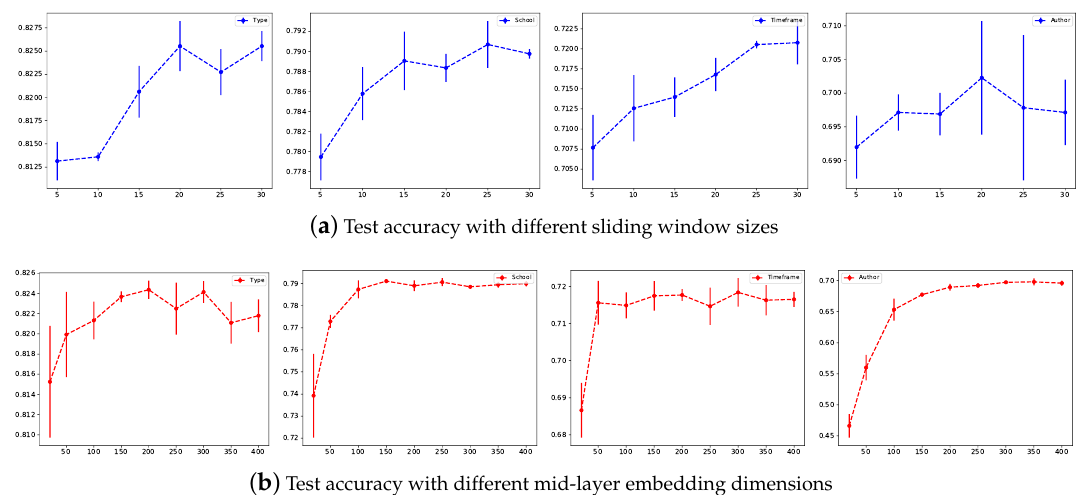
( b ) Test accuracy with different mid-layer embedding dimensions Figure 4. Test accuracy under different sliding window sizes and mid-layer embedding